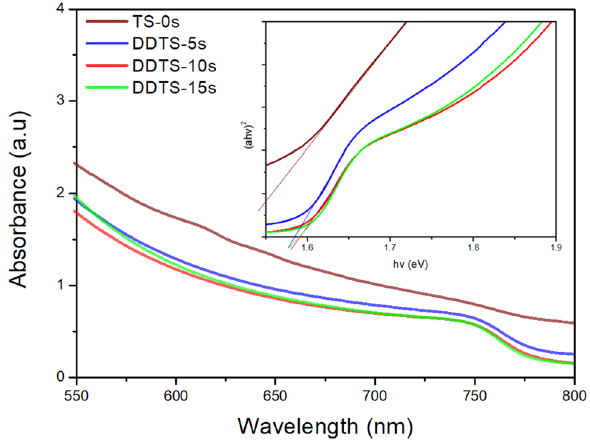
Fig. 4 Absorbance spectra of perovskite films with a regulated time delay (from 0 to 15 s). The Tauc plot of each sample is plotted in the